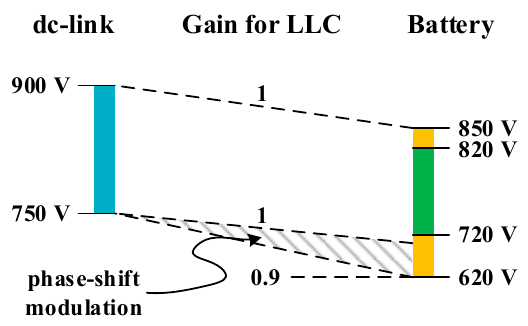
Figure 14. Gain of the LLC converter with n = 1.06 for variable dc-link voltage (750–900 V) covering the nominal battery voltage range.